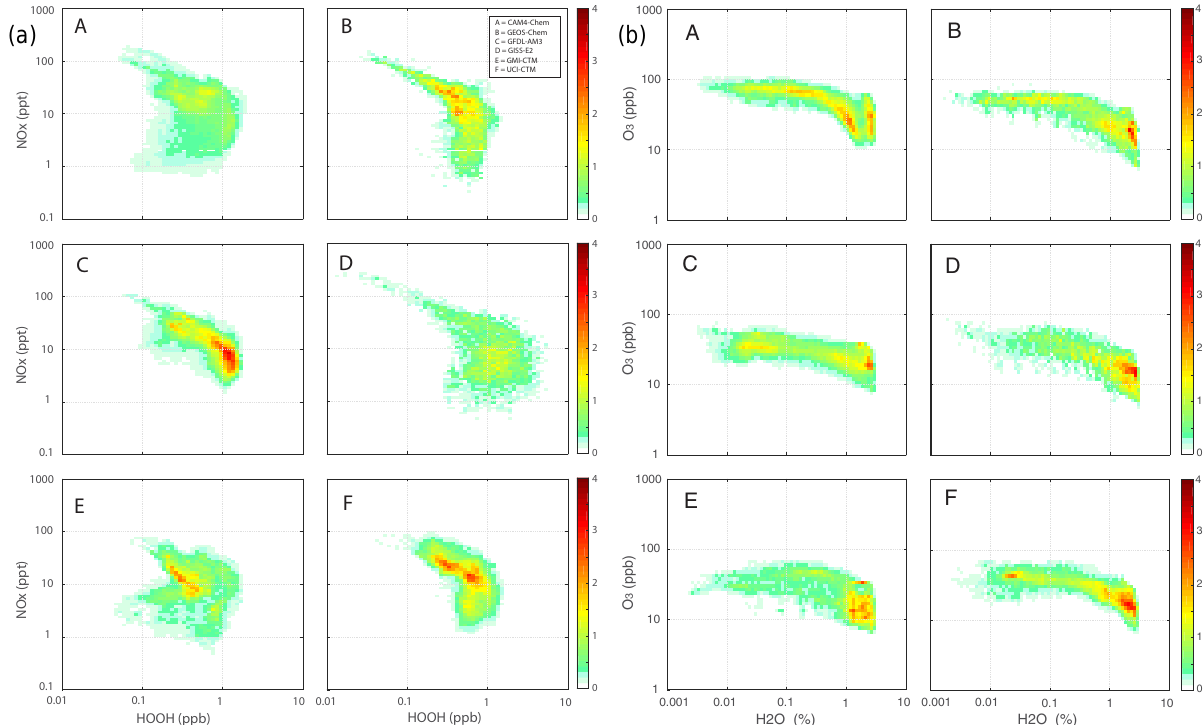
Figure 6. (a) Six modeled 2-D probability distributions for NO x vs. HOOH as weighted by air mass. These are the initial chemical abun- dances for each model and hence the same for A- and C-runs. All grid cells were binned at 20 per decade in species abundance (mole fraction, ppt for NO x , ppb for HOOH). The density value for each plot is scaled so that a uniform distribution over exactly 1 decade in both species would give the yellow-green color of 1.0. The domain being sampled in the models is the tropical Pacific: 20 ◦ S–20 ◦ N, 150–210 ◦ E, 0.5–12km. Model A = CAM4-Chem; B = GEOS-Chem; C = GFDL-AM3; D = GISS-E2; E = GMI-CTM; F = UCI-CTM. (b) Six modeled 2-D probability distributions for O 3 vs. H 2 O as weighted by air mass. This color-bar scale differs slightly from other 2-D plots. See (a)